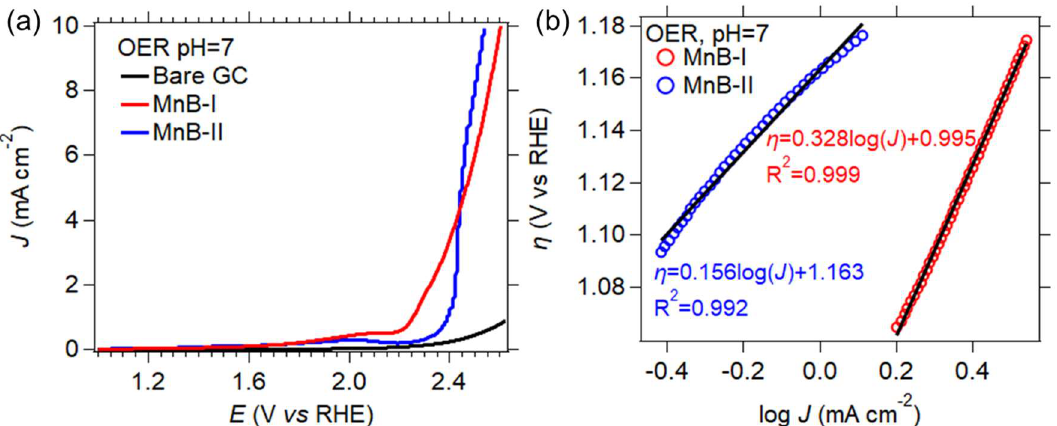
Figure 10. ( a ) Current density ( J ) vs. potential ( E ) linear polarization curves obtained from hydrogen evolution linear sweep voltammetry (LSV) scan at 1 mV∙s − 1 in pH 7 electrolyte; ( b ) HER Tafel plots of all samples in electrolytes with a pH 7 derived from the linear polarization curves. Linear regressions are represented by the black lines, and the equations of the linear fits are also shown.